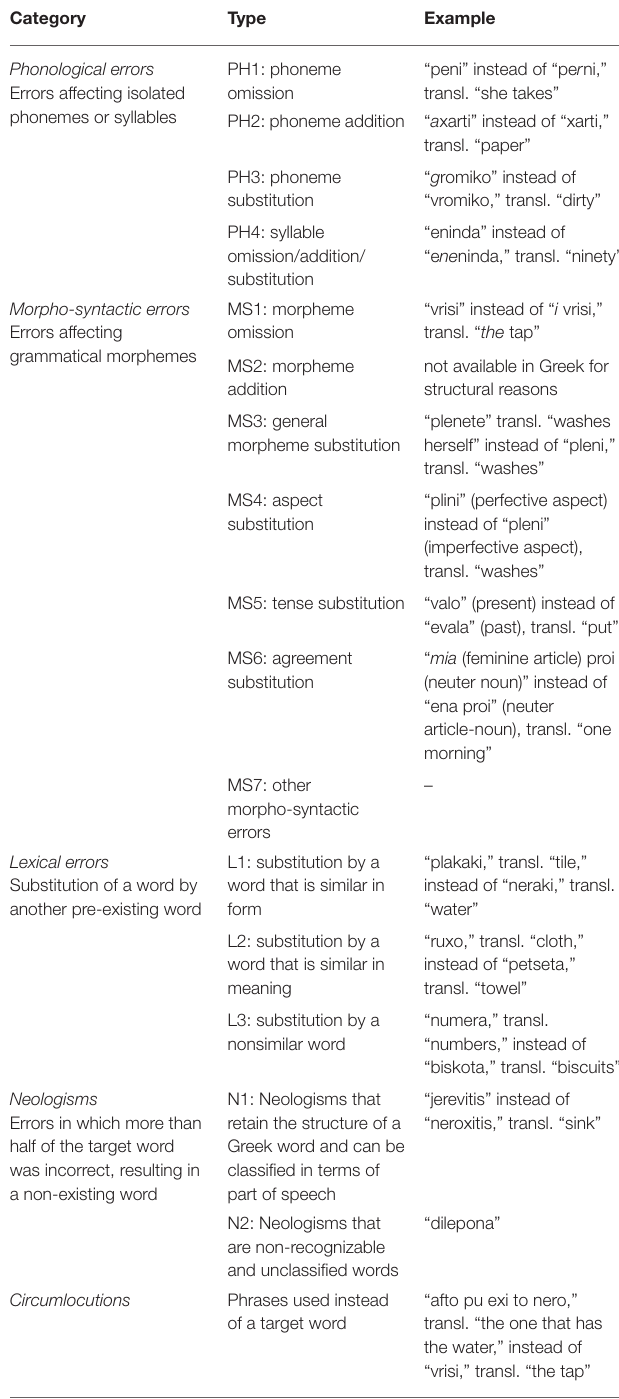
TABLE 2 | Error categories in the